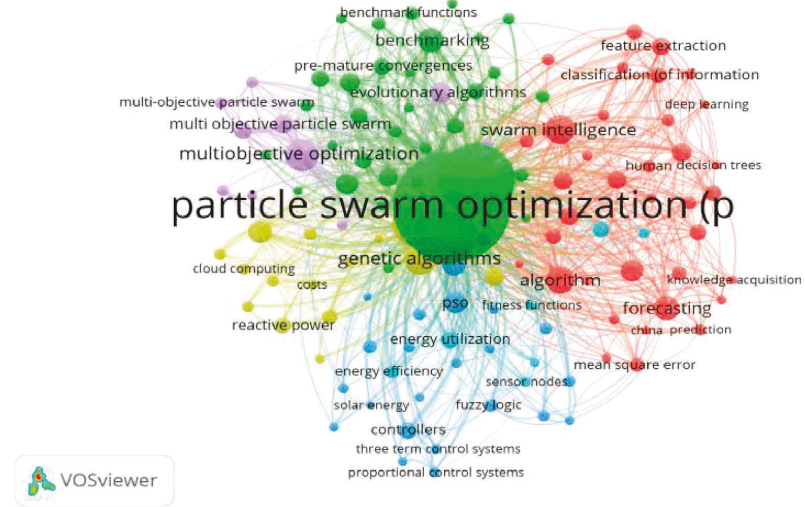
Figure 11: Network visualization of co-occurring keywords on PSOA research.